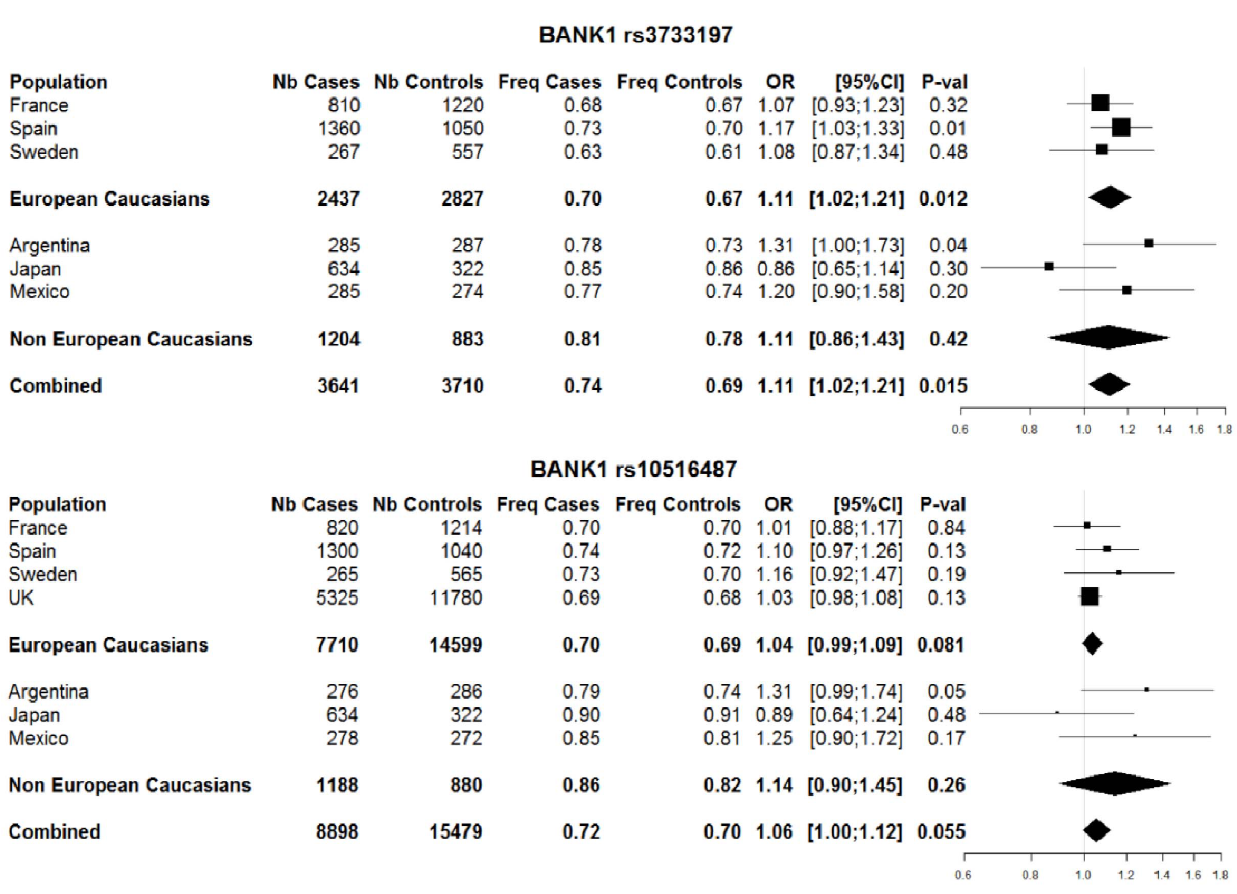
Figure 3. Meta-analysis of association of BANK1 alleles and rheumatoid arthritis. Number of cases and controls; frequency of the G allele in cases and controls; and OR, 95% CI and P -value for the association for each population separately and for European Caucasians and non-European Caucasians and the combined dataset. All data were obtained from the literature, except for the France and Japan data, for which new genotyping was performed for this study.